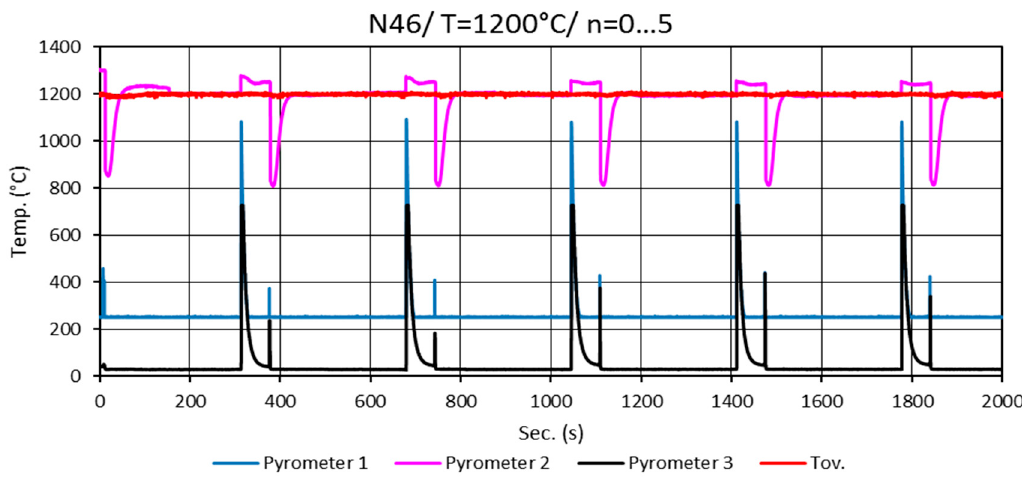
Figure 11. Thermogram for thermal shock cycles 38–43, temperature range 800–1300 °C .